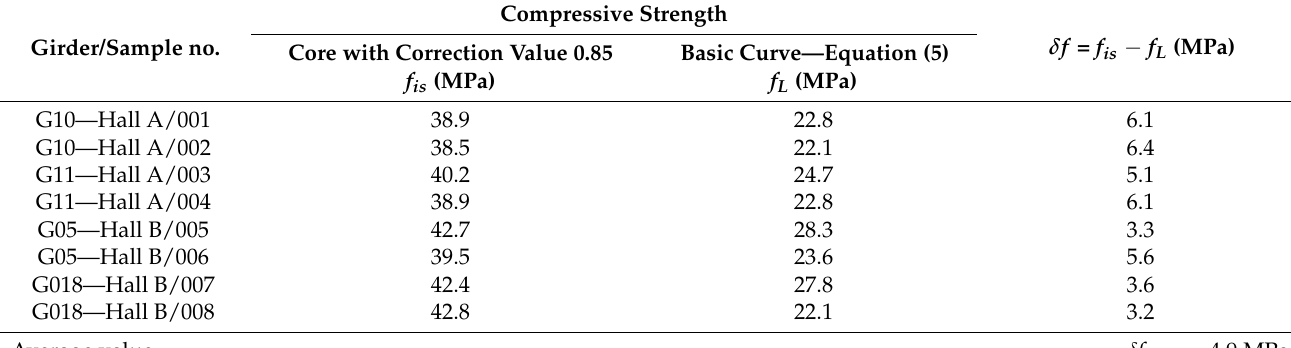
Table 7. Calculations for the base curve offset